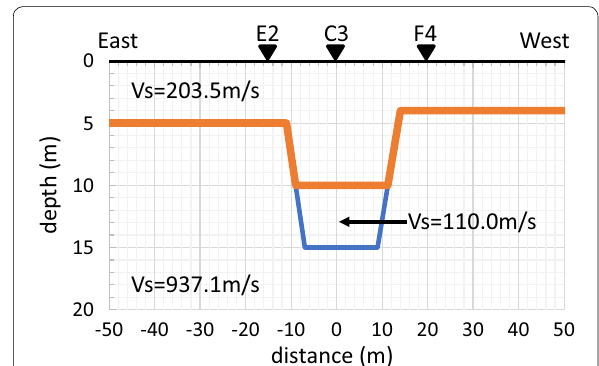
Fig. 13 Cross section of the 2-D wedge used for 3-D SEM calcula- tion. The relative location of points E2, C3 and F4 is shown when we assume that the wedge is in the NS direction